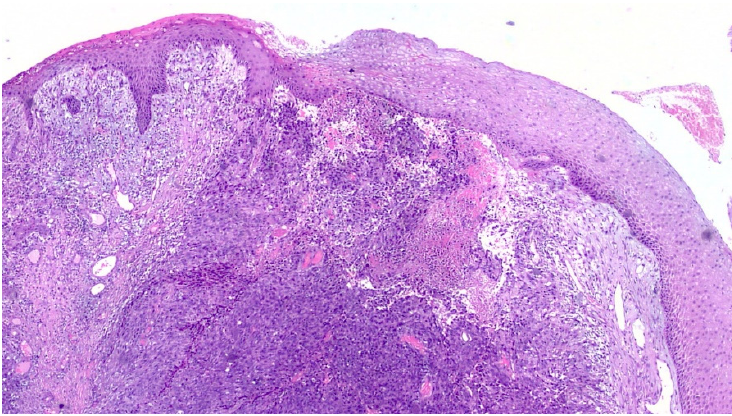
Figure 4. Low power view of a poorly demarcated lesion, located in the upper lamina propria (Hematoxylin & Eosin, ×2).